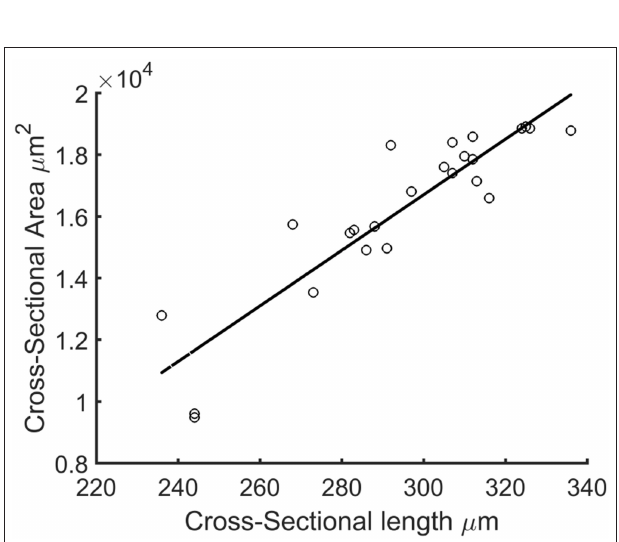
FIGURE 3 | (A) Middle slice of a 3D image form a collagen-stained microtissue. (B) Determining the cross-sectional area by using a convex hull on the middle lateral slice form the 3D image. (C) DAPI stained a microtissue. (D) Watershed filtering of cell nuclei. (E) Segmenting and counting the cell nuclei in 3D, where every individual nucleus has a different color.